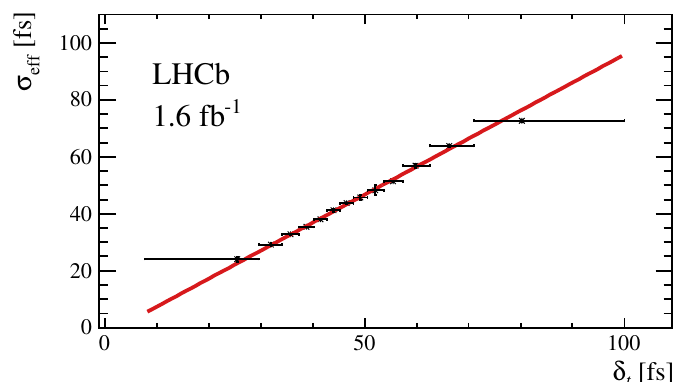
Figure 1 . Dependence of the e(cid:11)ective decay-time resolution, (cid:27) e(cid:11) , on the estimated decay-time uncertainty, (cid:14) t , for the background-subtracted data sample of J= linear (cid:12)t is